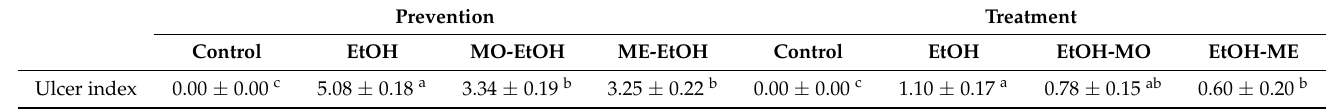
Table 3. Effect of myrrh oil and myrrh extract on ulcer